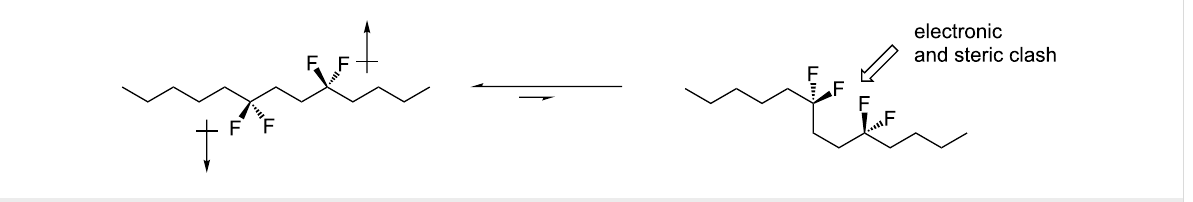
notable in that it was significantly higher than that of the two other analogues 6a and 6b , and also of palmitic acid itself. The solid state structure of 6c and 27 show that the 1,4-di-CF 2 motif prefers an anti- zig-zag conformation. We attribute this prefer- ence to intramolecular dipole–dipole relaxation which is maximised in the extended anti- zig-zag chain conformation (Figure 8). Also repulsive through space 1,4-F···F interactions will be disfavoured if the chain undergoes gauche con- formational disorder. These contributing factors suggest that the 1,4-di-CF 2 motif (R–CF 2 CH 2 CH 2 CF 2 –R) will be useful for adding conformational stability to aliphatic